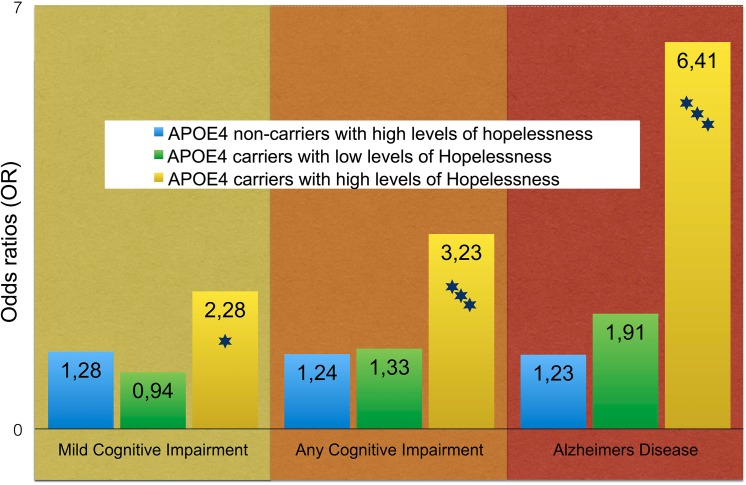
Levels of hopelessness at baseline and follow-up for the different outcome groups.Changes in hopelessness scores from baseline until follow up for those who at follow-up were either without cognitive impairment or were diagnosed with any cognitive impairment, mild cognitive impairment or Alzheimer’s disease. No changes from baseline to follow-up were statistically significant within any of the outcome categories (Student t-test for independent samples). All differences between the non-impaired group and any of the cognitive impairment groups were statistically significant, both at baseline and at follow-up (* = p≤0.05, ** = p≤0.01, *** = p≤0.001 as indicated by Students t-test for paired samples). The graph is based on scores from participants with measurements of hopelessness both at baseline and follow-up (N = 1246).